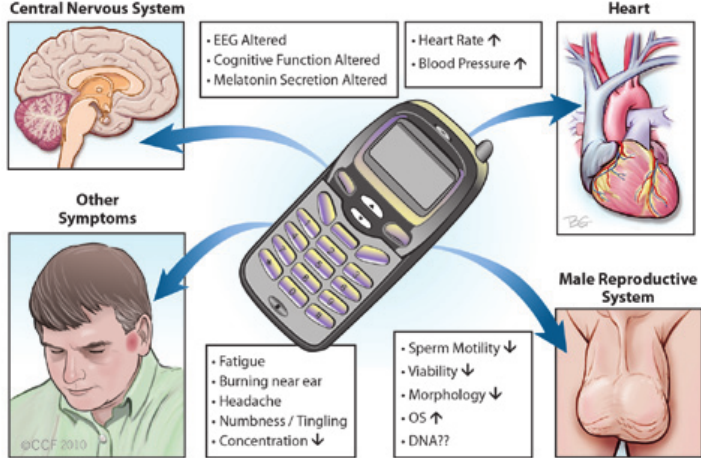
Figure 1 - Effects of Cellular Phone Usage on the Human Body. Usage of cellular phones is associated with alterations in various body systems including the central nervous system, cardiovascular system, and male reproductive system. Adapted from Makker 2009